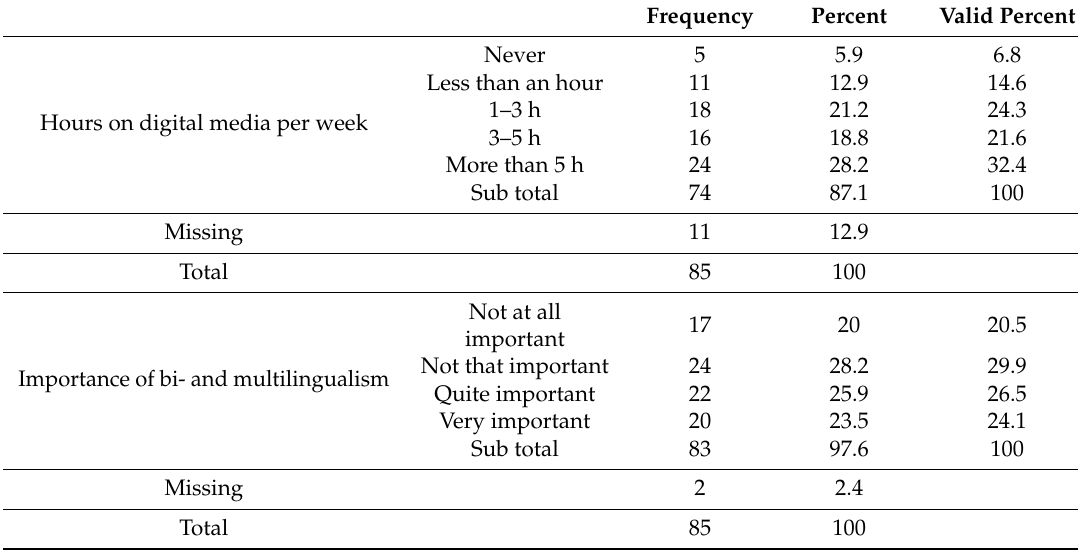
Table 4. Frequency table of hours spent of digital media and of the importance of